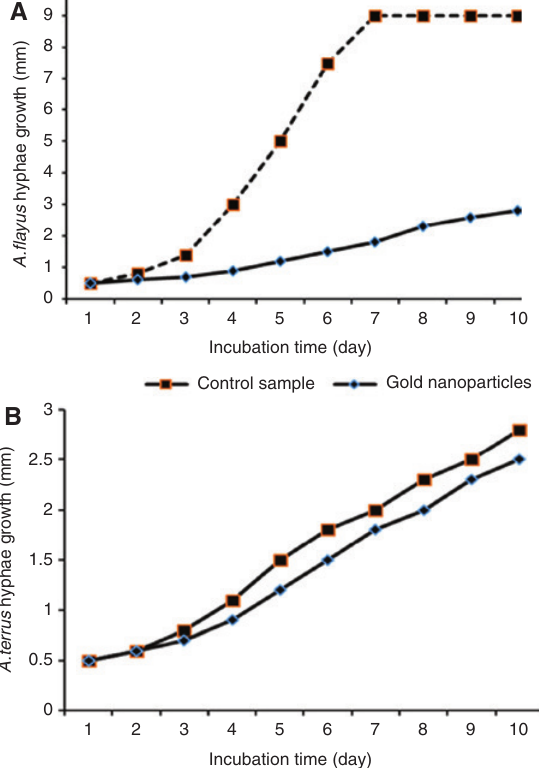
Figure 10: Antifungal effects of the synthesized AuNPs obtained at optimum conditions on A. flavus (A) and A. terreus (B). Data are the mean value of three replicates (each replicate contains four